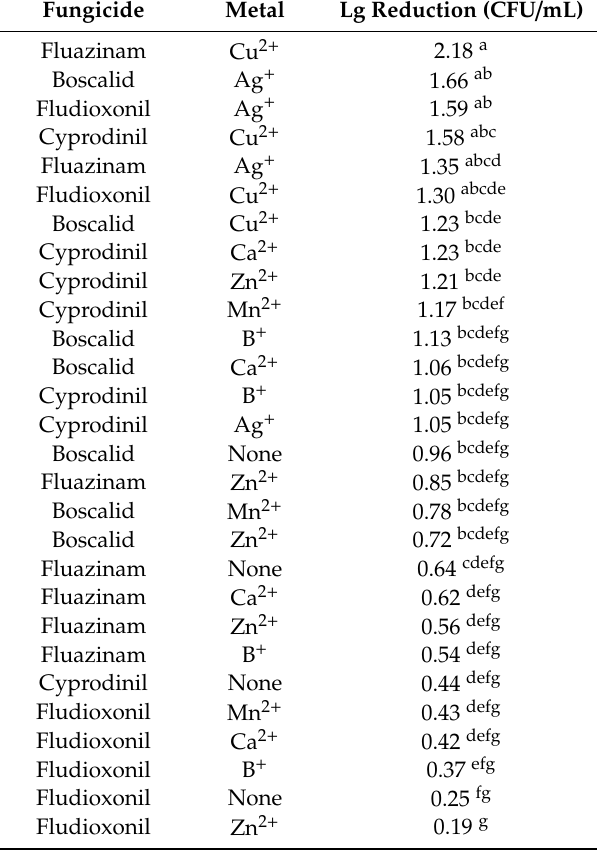
Table 1. Lg reduction in colony forming units (CFU) / mL in Sclerotinia sclerotiorum biofilms for combinations of four fungicides with six metallic cations. Means that do not share a letter in common are significantly di ff erent at p ≤ 0.003.